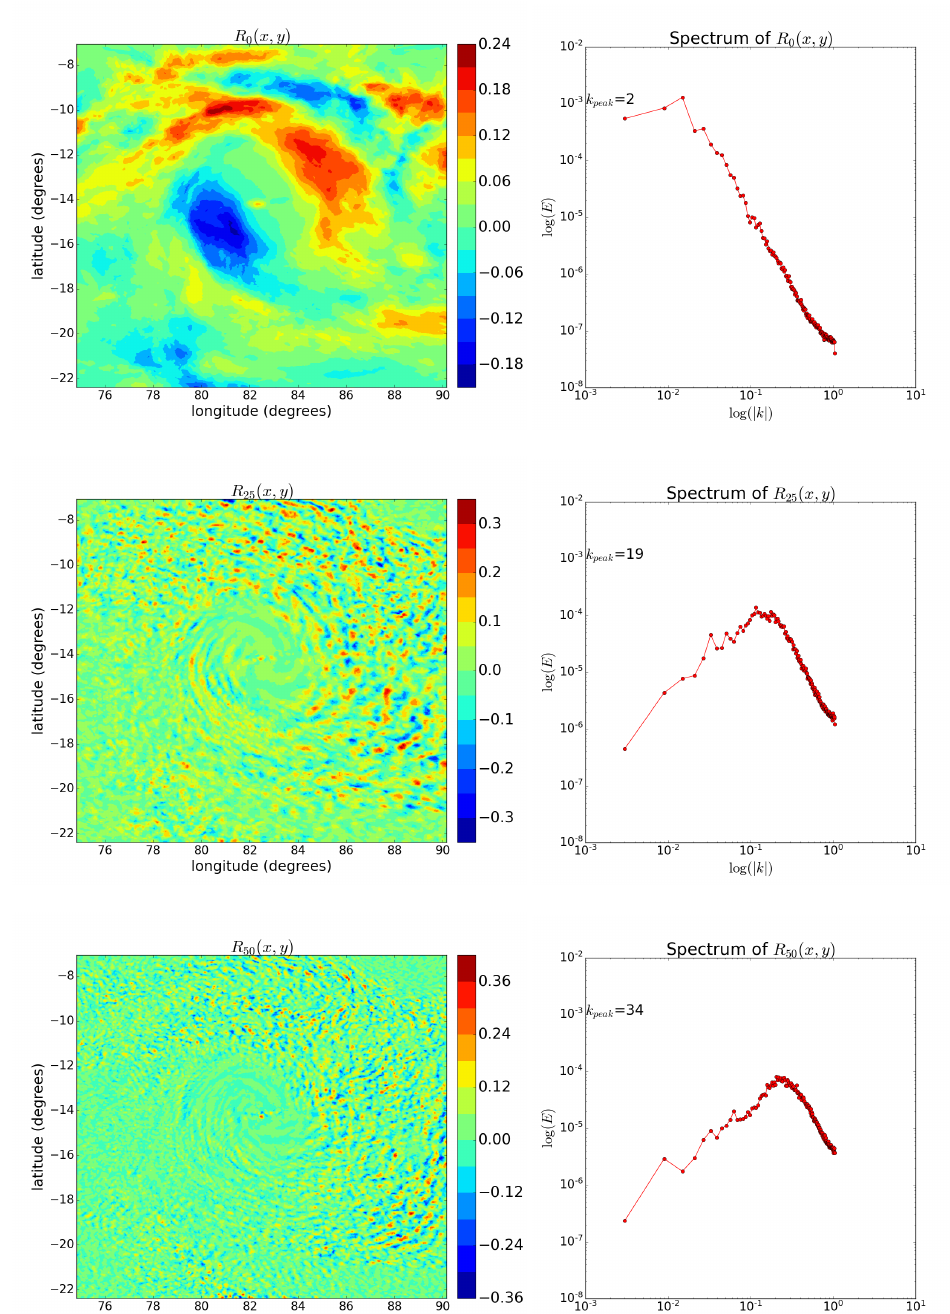
Figure 7. Left panels: contour plots, as a function of longitude and latitude for the eigenfunctions order j = 0 ( a 1 ), j = 25 ( a 2 ) and j = 50 ( a 3 ) (corresponding to large, intermediate and small scales) for the Faraji cyclone. Right panels: shell-integrated Fourier spectra in double logarithmic scales for the eigenfunctions order j = 0 ( b 1 ), j = 25 ( b 2 ) and j = 50 ( b 3